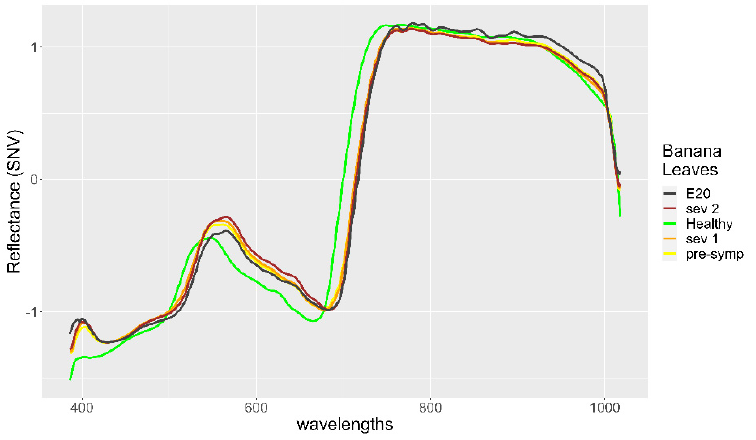
Figure 5. Spectral signature of 20th leaf (E20 black color) compared with the spectral signature of healthy banana leaves and infected banana leaves.